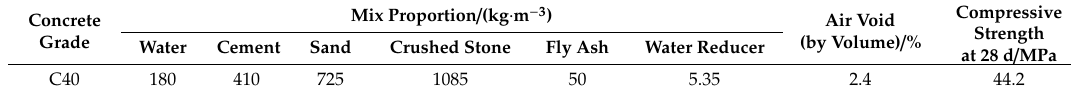
Table 5. Mix proportion and major parameters of